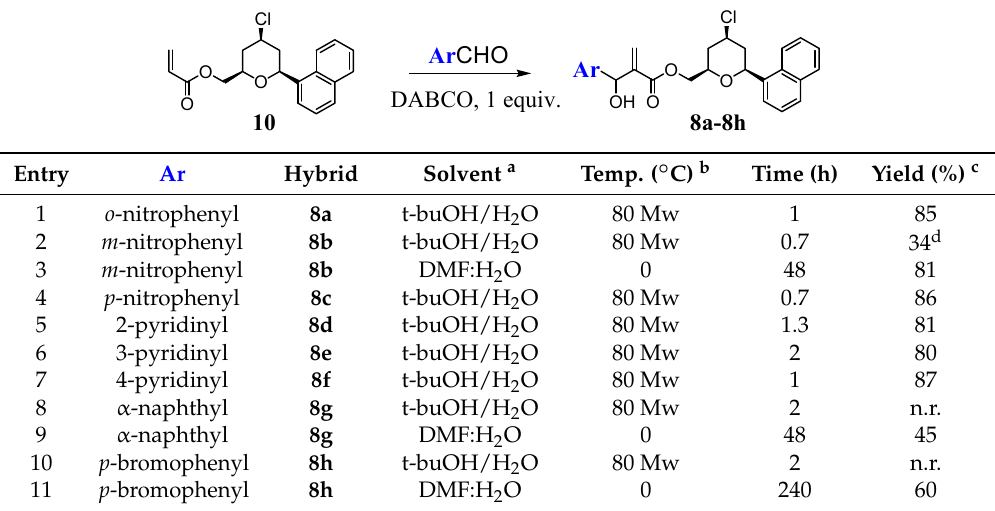
Table 2. Conditions and yields in the synthesis of new hybrids 9a – 9h.